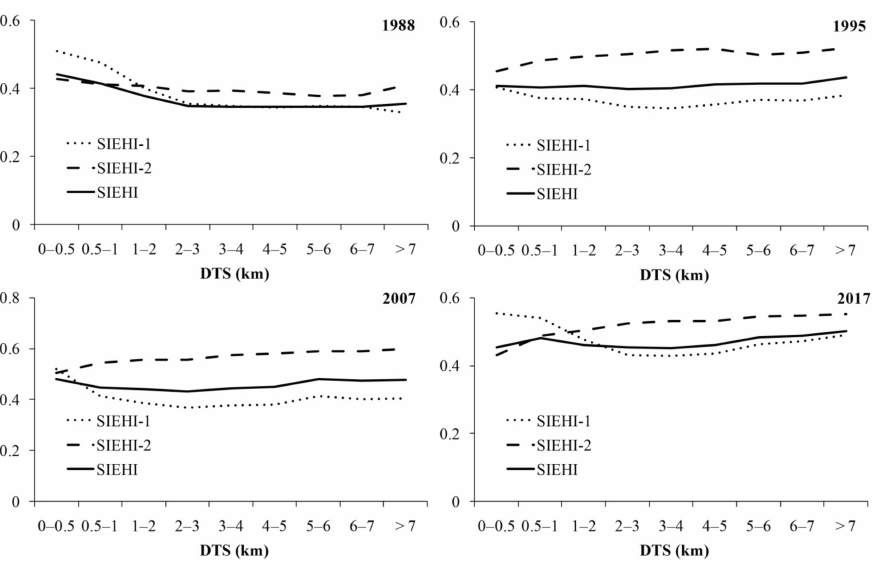
Figure 12. Changes of the sandy island ecosystem health along the gradient of distance to shoreline (DTS): SIEHI: sandy island ecosystem health index; SIEHI-1: Part 1 of the SIEHI; SIEHI-2: Part 2 of the